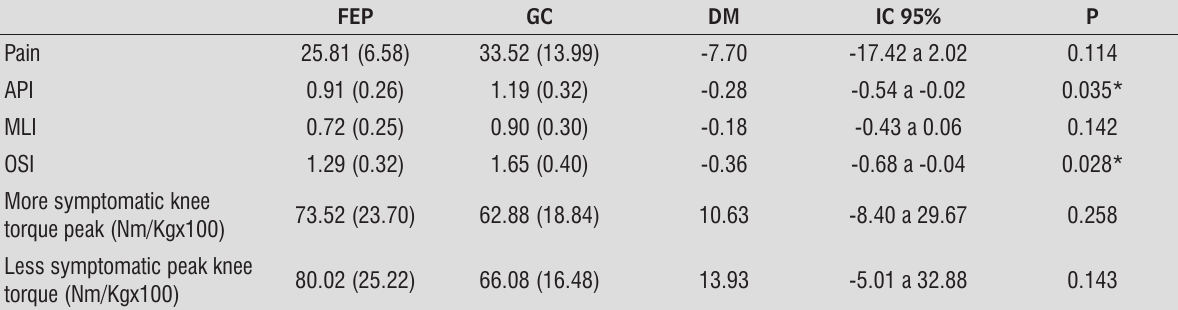
Table 3 - Pain evaluation, postural balance and muscle strength after 12 weeks of